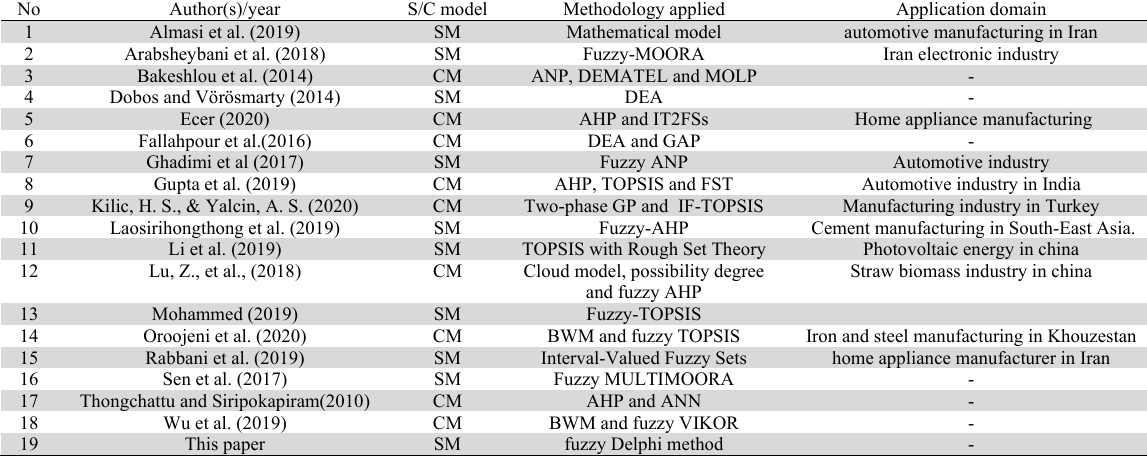
The recent studies on GSS using MCDM